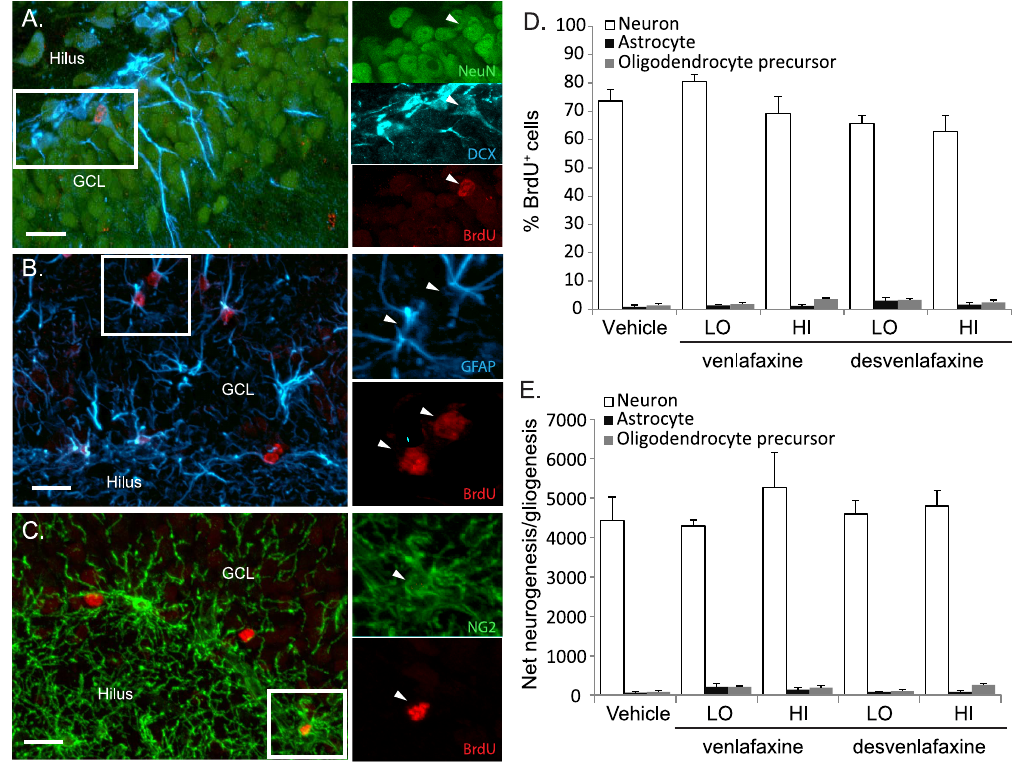
Figure 3. Anti-depressant treatment doesnot influence NPC differentiation in the DG of adult rats. A ) Representative confocal images of a new transitionstate neuron ( A ), astrocytes (B ) and an oligodendrocyte precursor ( C )in the dentate gyri of adult male rats. Figure ( A )shows new BrdU + cells in red, DCX + immature neurons in cyan and NeuN + mature neuronsin green. The inset shows a new transition state neuron thatwas BrdU + (red) and expressed bothDCX (Cyan) and NeuN (green). Each signalis shown separately in the panels. Figure B )shows new BrdU + cells in red and astrocytes ingreen. The inset shows new astrocytes that were BrdU + and expressed GFAP. Each signal is shown separately in the panels.Figure C ) shows new BrdU + cells in red and NG2 + oligodendrocytes precursorsin green. The inset shows a new NG2 + oligodendrocyte precursor (in green) that was BrdU + (red).Each signal is shown separately in the panels. D )Although a greater % of new (BrdU + )cells acquired a neuronal versus astrocyte or oligodendrocyte precursor phenotype,phenotype was not impacted by antidepressant treatment. E) Similarly, total new neuron number was greaterthan either the total new astrocytes or new oligodendrocytes precursor number (p values , 0.0001) but the total number of newneurons and glia was unaffected by antidepressant treatment ( p =0.84).All data are expressed as mean 6 S.E.M.